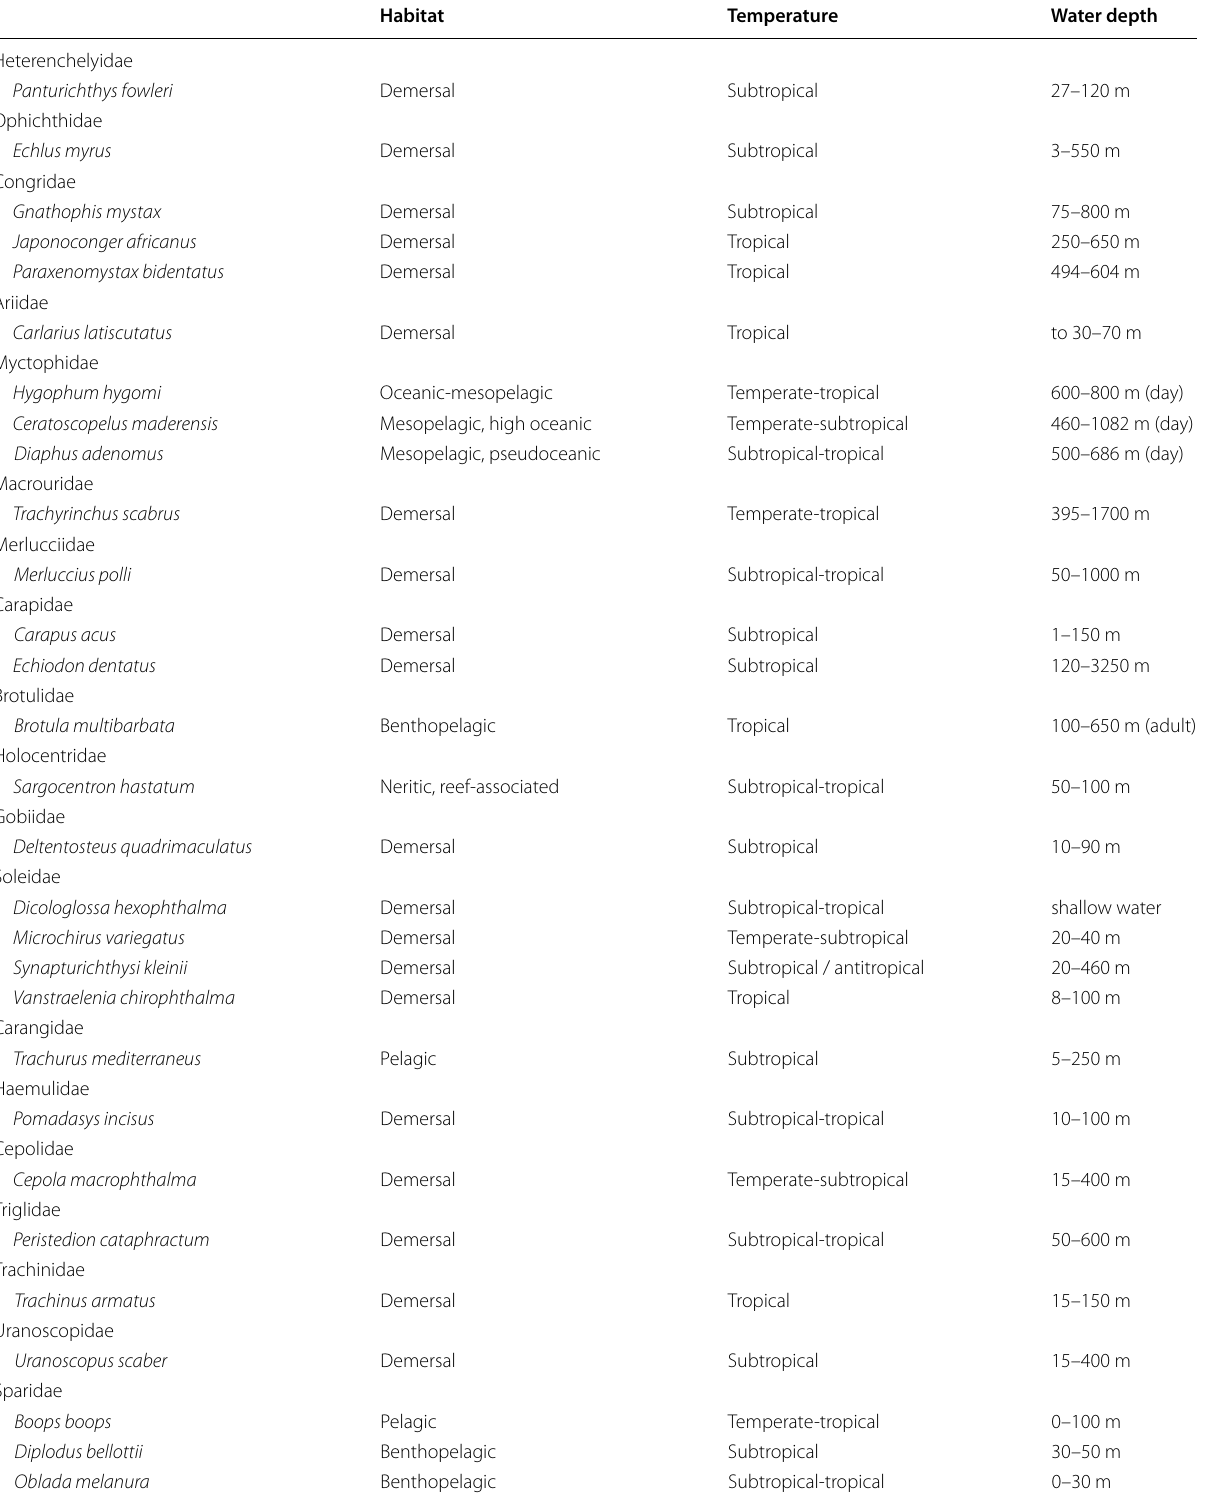
Table 2 Ecology chart of extant species found as fossils in Dar bel Hamri. Ecology data from Froese and Pauly (2022); depth ranges reflect “usual ranges” where